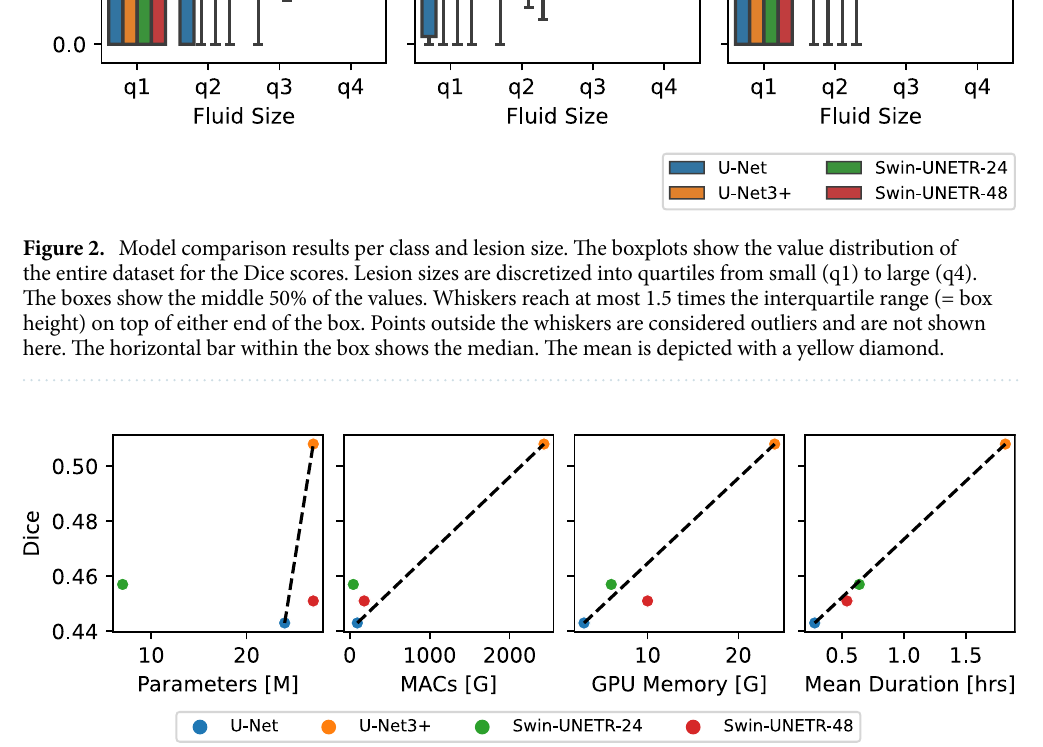
Figure 3. Comparison of the methods’ computational efficiency across four different metrics. The mean cv5- Dice score over the classes is plotted against the total number of trainable parameters (top-left), the number of multiply-accumulate operations (MACs) (top-right), the measured GPU memory used during training (bottom- left), and the mean training duration over the folds (bottom-right). The dotted line represents the relationship between the two methods with the lowest and highest Dice